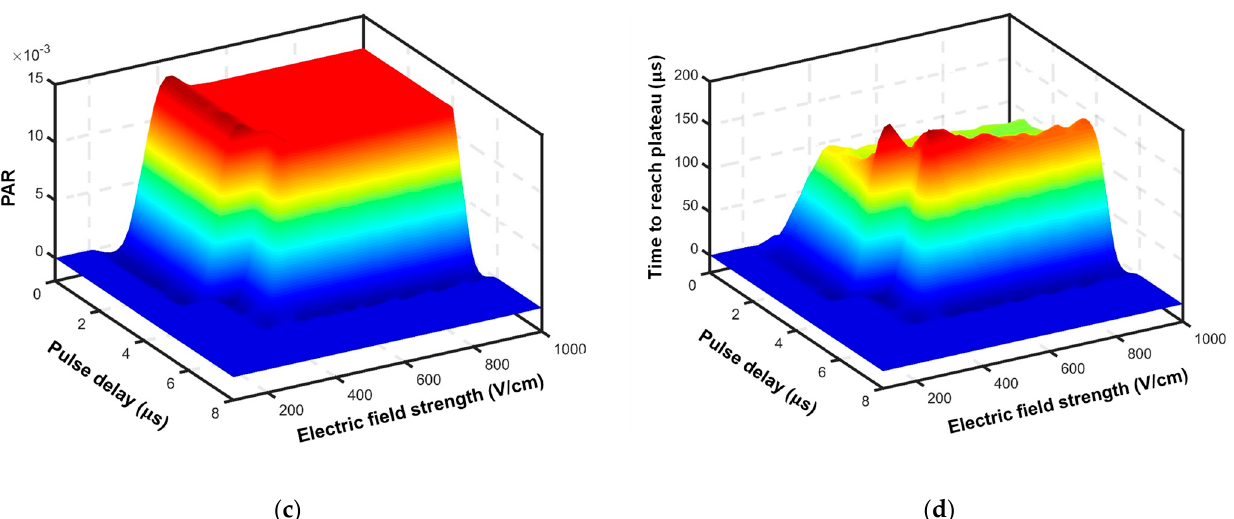
Figure 6. The joint effect of the pulse delay and the electric field strength on ( a ) PAR and ( b ) the time required to reach plateau when the pulse width is 1 μs ; The joint effect of the pulse delay and the electric field strength on ( c ) PAR and ( d ) the time required to reach plateau when the pulse width is 2 μs .